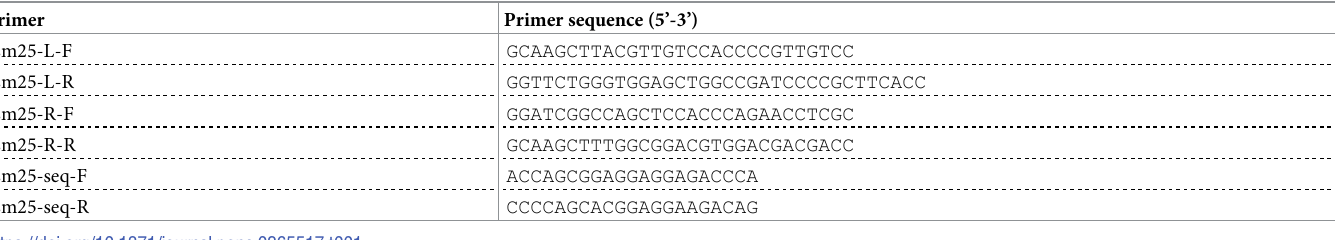
Table 1. Primers used in this